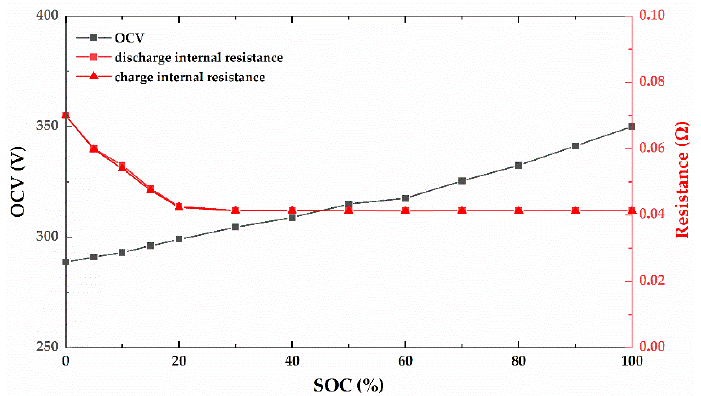
Figure 4. Characteristic curves of the lithium-ion battery.